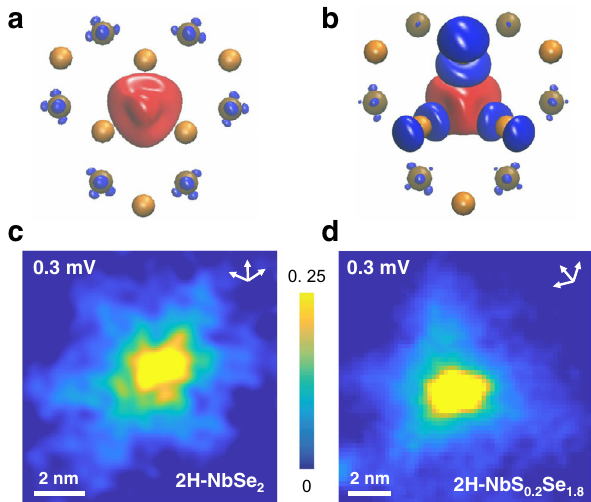
Fig. 3 YSR states at magnetic impurities. Spin-density isosurface of 2H- NbSe 2 ( a ) and of 2H-NbSe 1.8 S 0.2 ( b ) obtained from DFT + U calculations. Red stands for spin up and blue for spin-down charge density. The isosurface is plotted for an imbalance by 0.002 of the spin density. The Fe atom (not shown) is located on the red spot, substituting a Nb atom. Se atoms are orange and Nb atoms ochre colors. We represent the two uppermost layers (Se and Nb) from the top. In b there are S atoms in layers below, shown in the Supplementary Fig. 4. Calculations are made on four layers, using 4 × 4 × 2 sized slabs (see Supplementary Note 3, for further details). c , d Measured tunneling conductance maps at a Fe impurity in 2H- NbSe 2 ( c ) and in 2H-NbSe 1.8 S 0.2 ( d ). White arrows provide the crystalline directions of the atomic Se height of the peak decreases exponentially with distance (lower right inset of Fig. 2b). Thus, we see that the effect of YSR states is transposed two orders of magnitude in distance, from λ F to ξ V , and leads to the electron-hole asymmetric CdGM states we dis- cuss below.